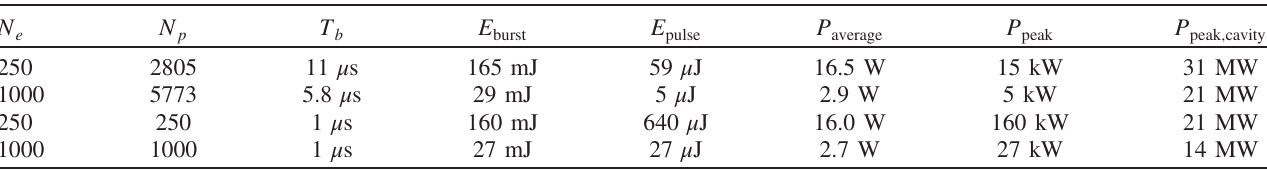
is the laser power stored in the cavity during collisions with electrons. peak ; cavity